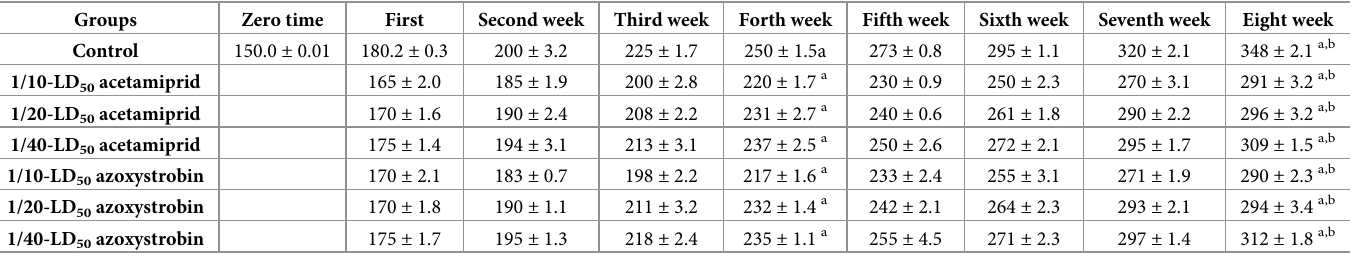
Table 4. Effect of acetamiprid and azoxystrobin on the body weight (g) of rats during the two months of exposure. Groups